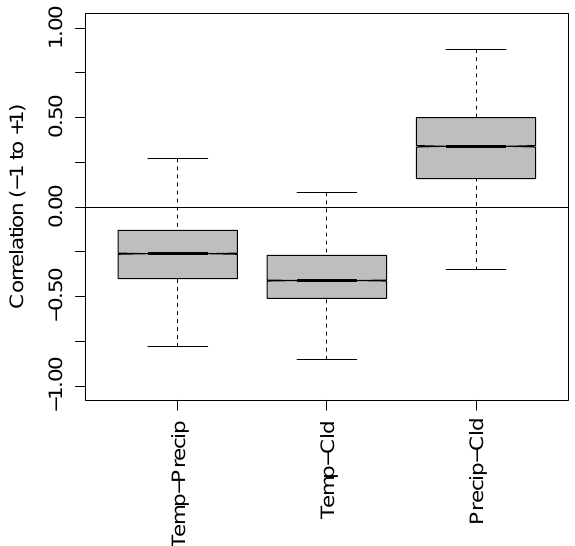
Figure 9. Box plots of the distribution for correlation between de- trended values of each environmental variable. The location of the box and in particular the median on the y axis, on either side of the zero line, reveals the predominant sign of the